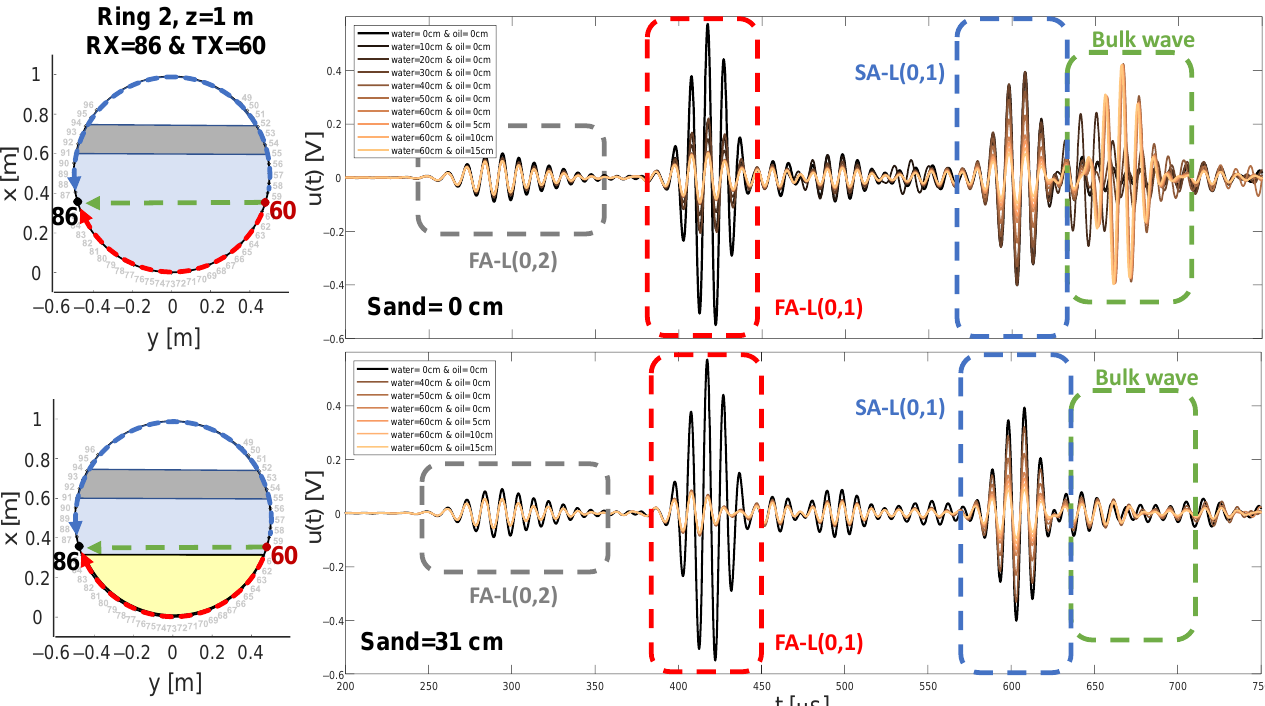
Figure 4. Exemplary signals for excitation with 100kHz at transducer number 60 and received at transducer number 86, at the sensor ring number two for various filling states without ( first row ) and with a 31cm sand filling ( second row ). The travel paths of first (red, FA) and second arrival (blue, SA) are color